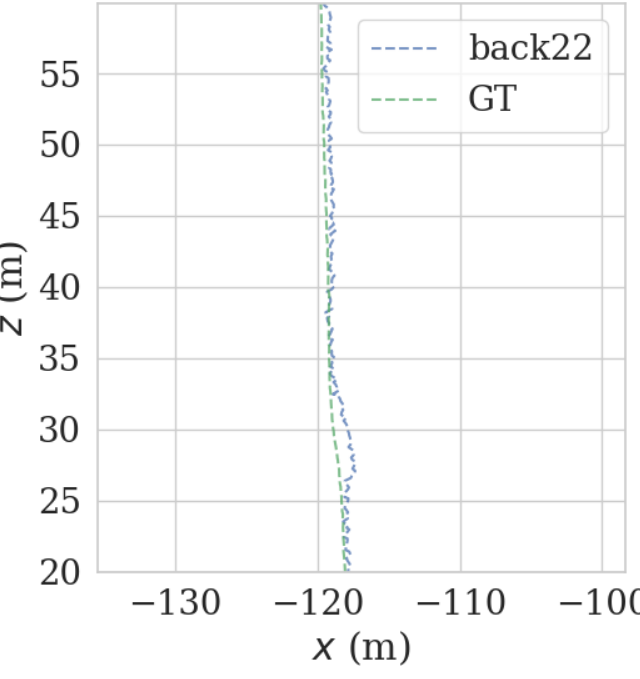
Figure 20. Track error using front-back LiDAR data on the straight